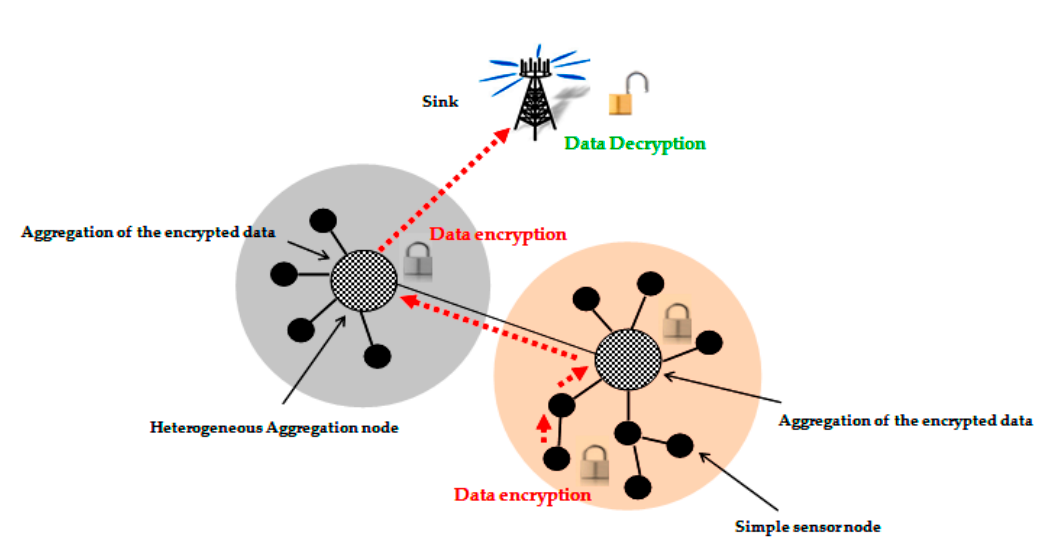
Figure 3. End to end data aggregation security approach.